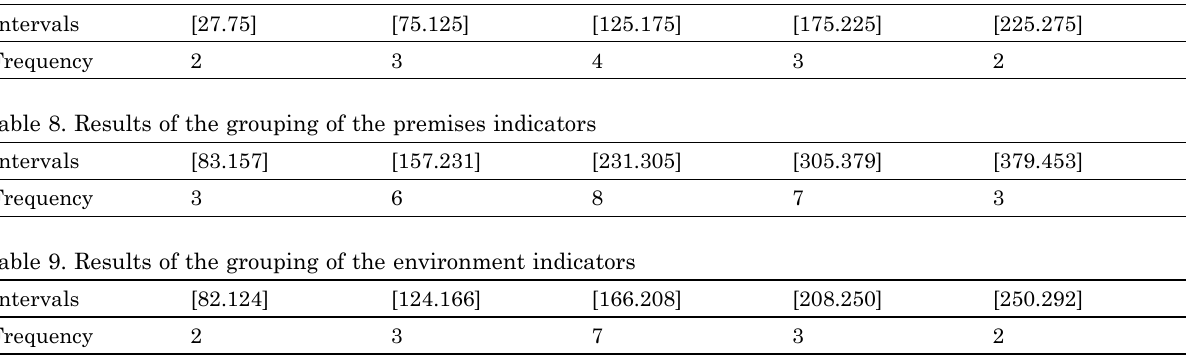
table 10. results of the grouping of the lease indicators according to their importance name of block of indicators